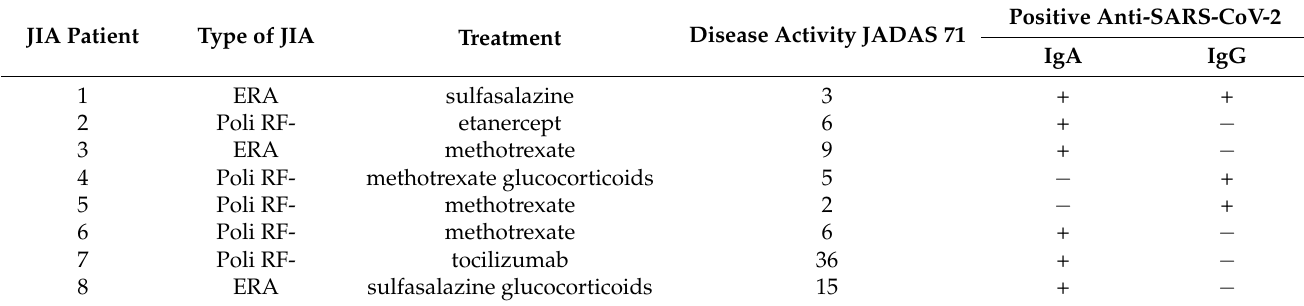
Table 3. Characteristics of SARS-CoV-2 antibody positive JIA patients.